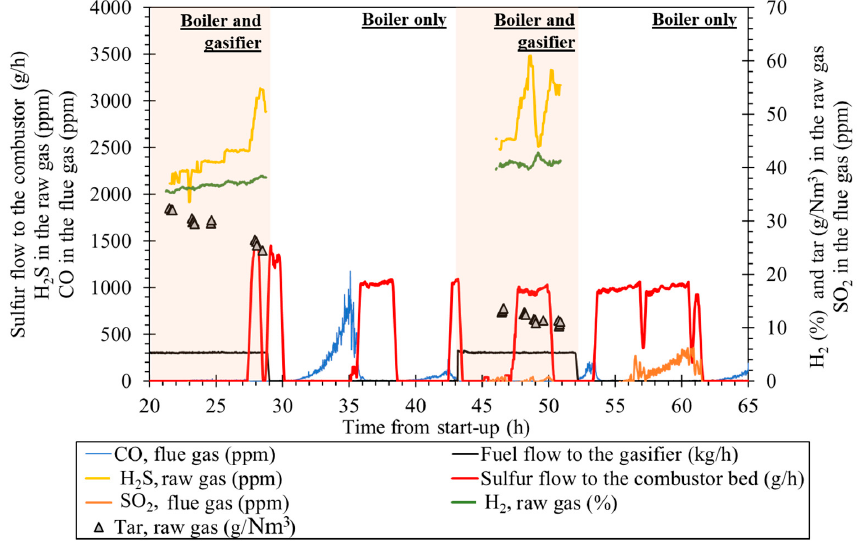
Figure 5. Influence of S addition on the concentrations of H 2 S, tar, and H 2 in the raw gas (gasifier). The raw gas concentration before any addition of chemicals to the system was sam- pled 21 hours after start-up of the DFB system. At that timepoint, approximately 100 kg of fuel ash had already entered the system. The raw gas showed a tar concentration of 32 g/Nm 3 , 35.5% H 2 , and 2300 ppm H 2 S. During the first few hours, the H 2 and H 2 S concen- trations in the raw gas showed a slow and steady increase of 0.3%/h, in line with the en- richment of the bed with the fuel ash. The addition of S to the bed at t = 27 h intensified the increase in H 2 yield, as shown in Figure 6. The increase in the H 2 yield was followed by an increase in the yield of CO 2 and a decrease in the CO yield, in line with the WGS reaction equilibrium. The yields of CH 4 and tar also decreased during the addition of S, reflecting the enhanced reforming reactions. In addition to the increased catalytic activity towards tar and the WGS reaction, the results show an increased char gasification rate with the addition of S. Based on the carbon balance calculations over the gasifier, the char gasification rate was estimated to be 6% at the reference measurement at t = 21 h, and it increased to approximately 19% during the feeding of S at t = 28 h.